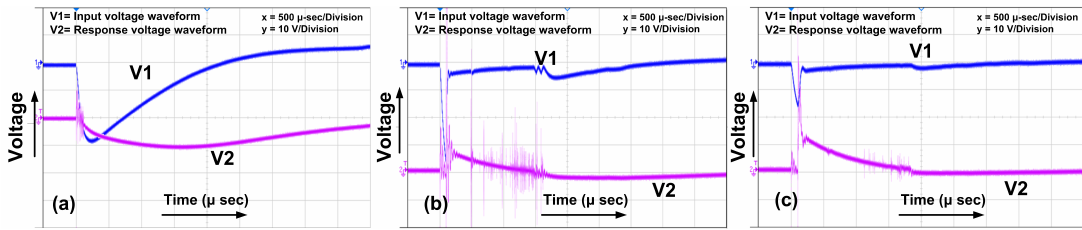
Figure 9. Comparison of the input and response voltage waveforms for the diagnosis of sources of PDs across major insulation ( a ) Normal case ( b ) PD-3-major ( c ) PD-4-major